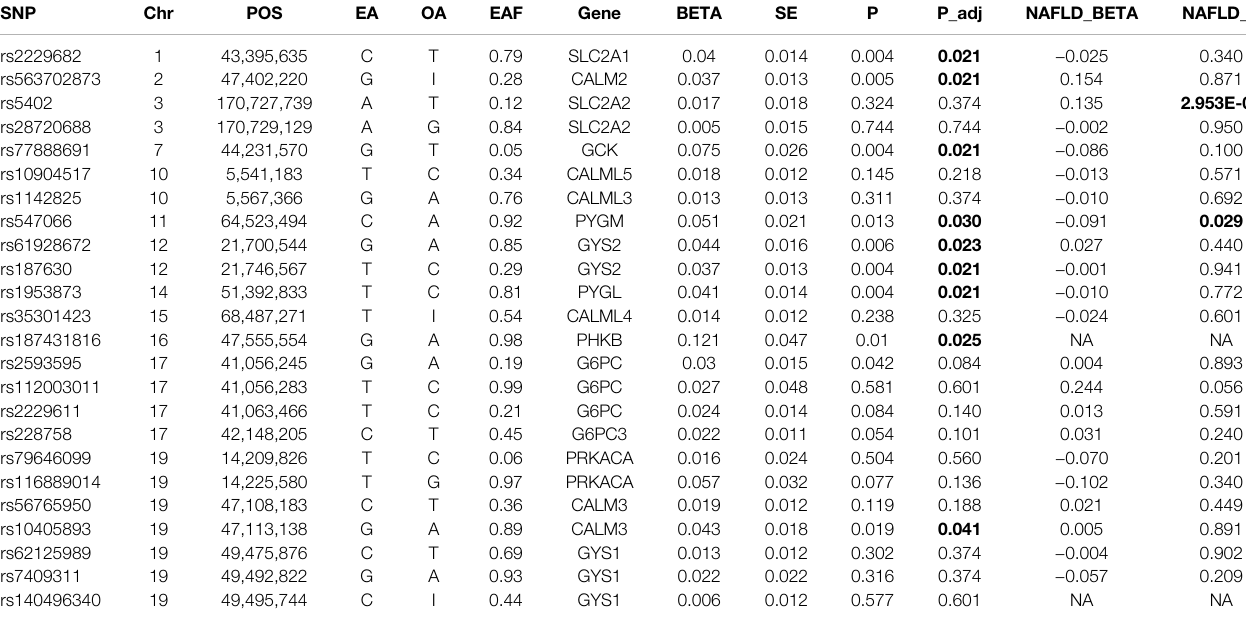
TABLE 2 | Associations of common SNPs in glycogen metabolism genes with PDFF and NAFLD. SNP Chr